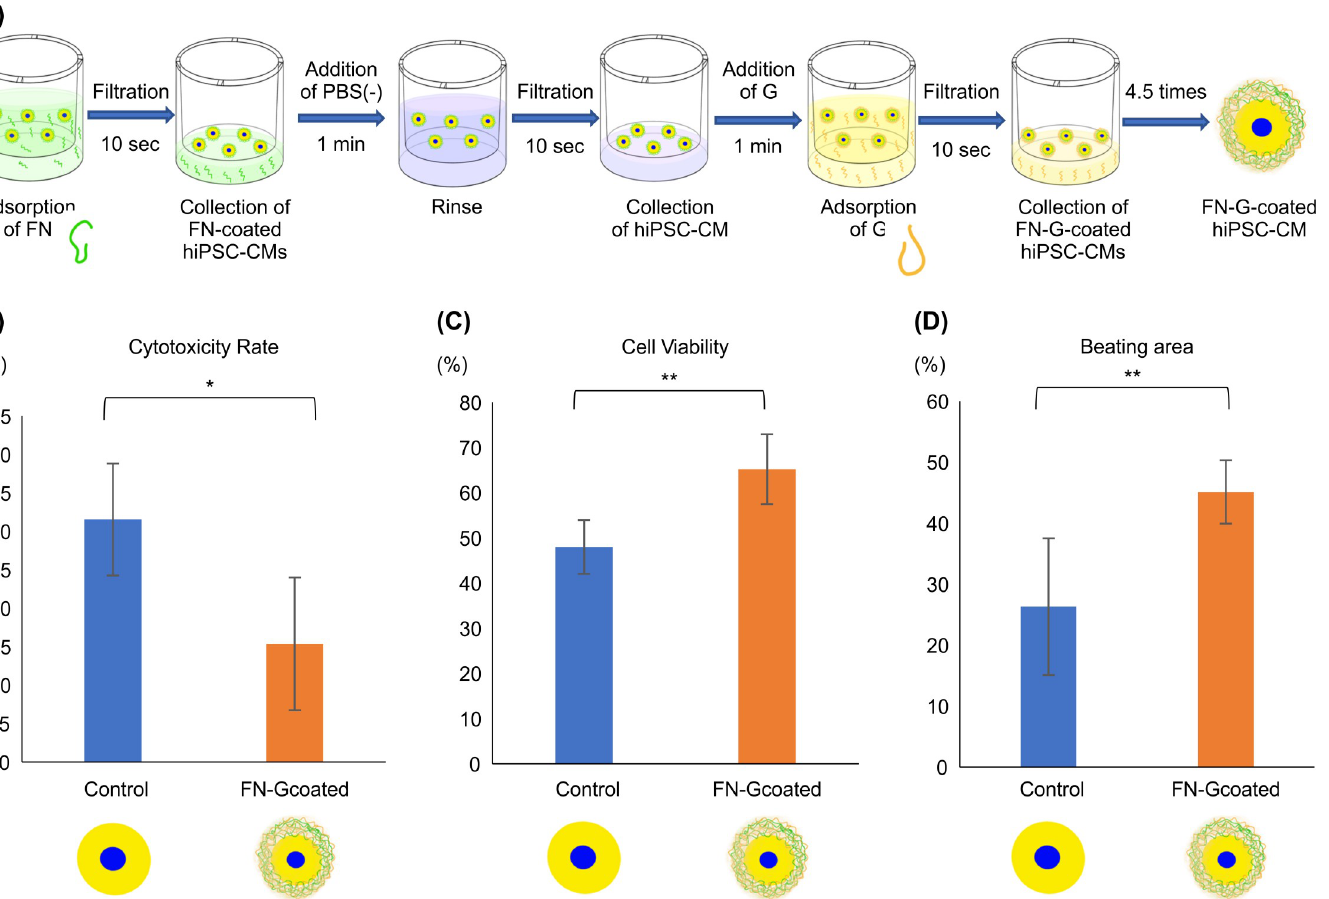
PLOS ONE | https://doi.org/10.1371/journal.pone.0245571 March 15,